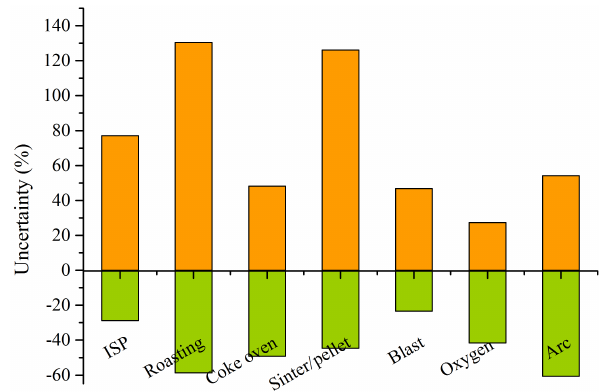
Figure 5. Uncertainty analysis.